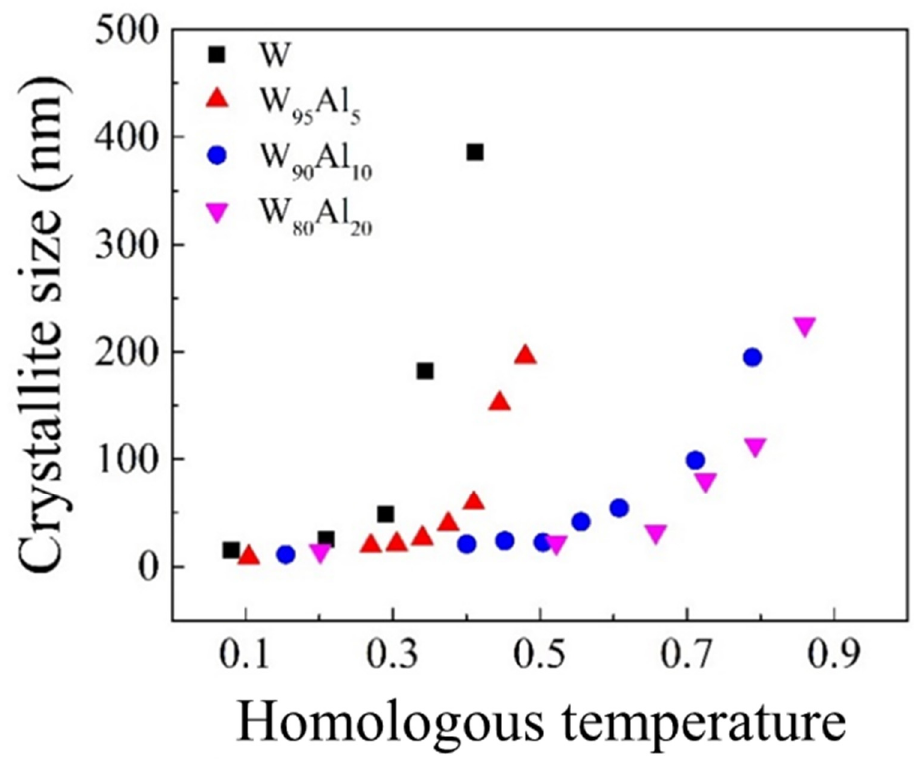
Figure 5. Equilibrium grain size of different W-Al alloys as a function of homologous temperatures. Values obtained for pure W are also included for comparison.